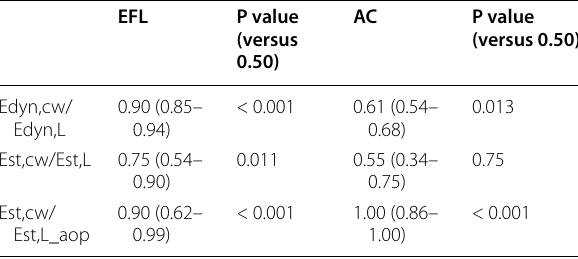
Table 1 Area under ROC curve (95% confidence intervals) for chest wall to lung elastance ratios to predict expiratory flow